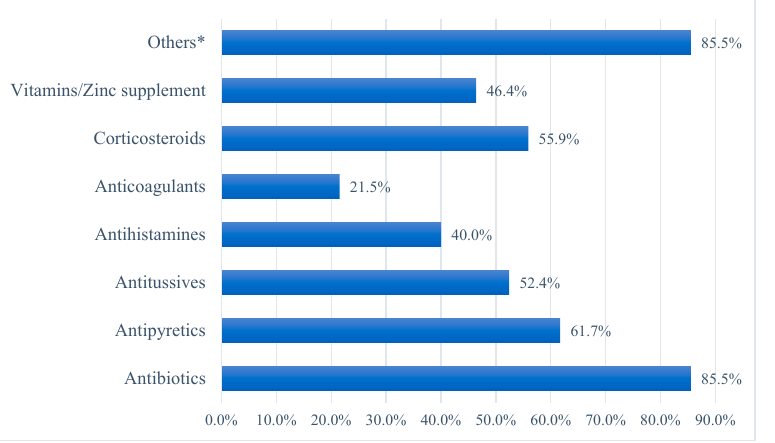
Figure 2. Details of medication prescribed to the study population. NB: * Intravenous fluids and/or inhalation fluids.